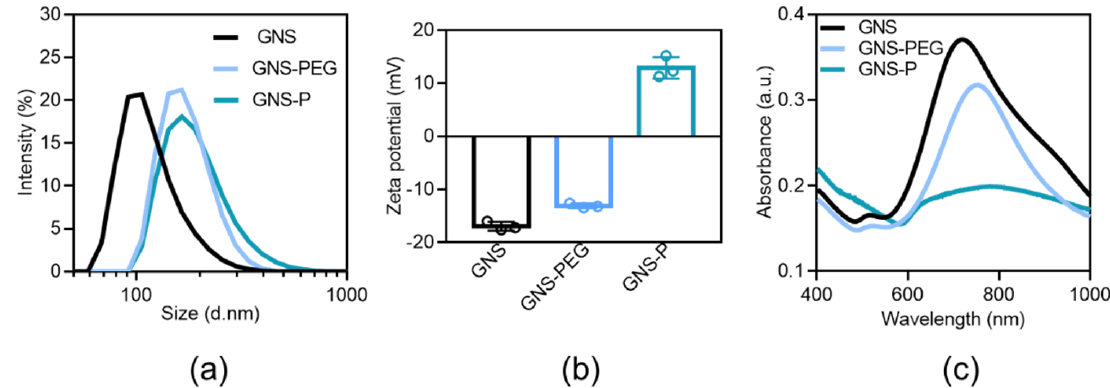
Figure 6. ( a ) Hydrated particle size distribution of GNS, GNS-PEG and GNS-P. ( b ） Surface poten- GNS-P. ( c ) UV Absorption Spectroscopy of GNS, GNS-PEG and GNS-P. tial of GNS, GNS-PEG and GNS-P. ( c ) UV Absorption Spectroscopy of GNS, GNS-PEG and GNS-P. Table 2. Characterization of GNS based nanoplatforms before and after Table 2. Characterization of GNS based nanoplatforms before and after modification.